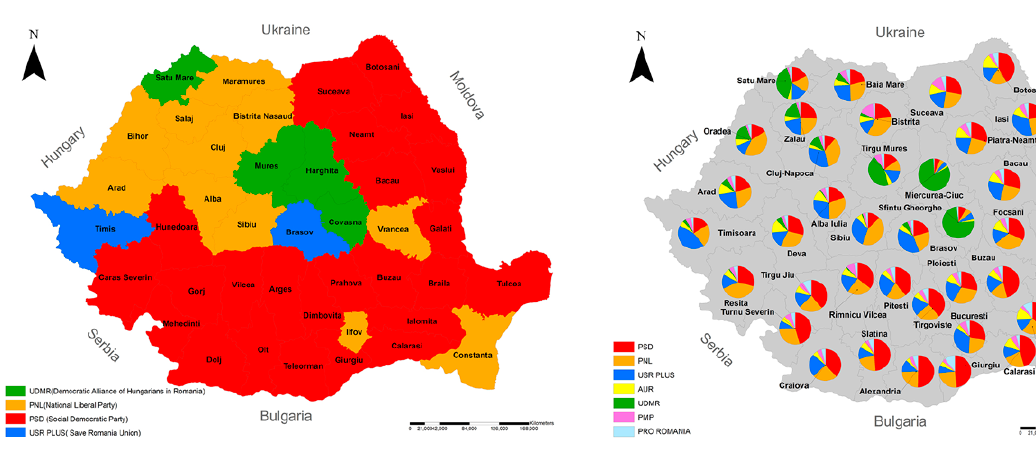
Figure 4. Winning parties by county, Romanian Figure 5. The results of the 2020 Parliamentary elections in Romania at the level of county capital municipalities